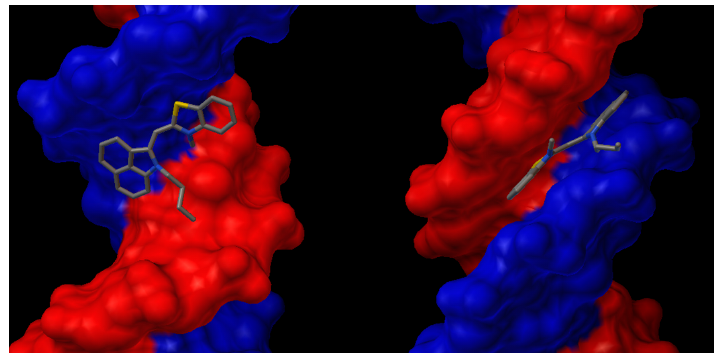
Figure 7. Dye 6b with fixed torsion angles and planar geometry suggested to bind to the major ( left ) and minor ( right ) grooves of dsDNA by computational studies.